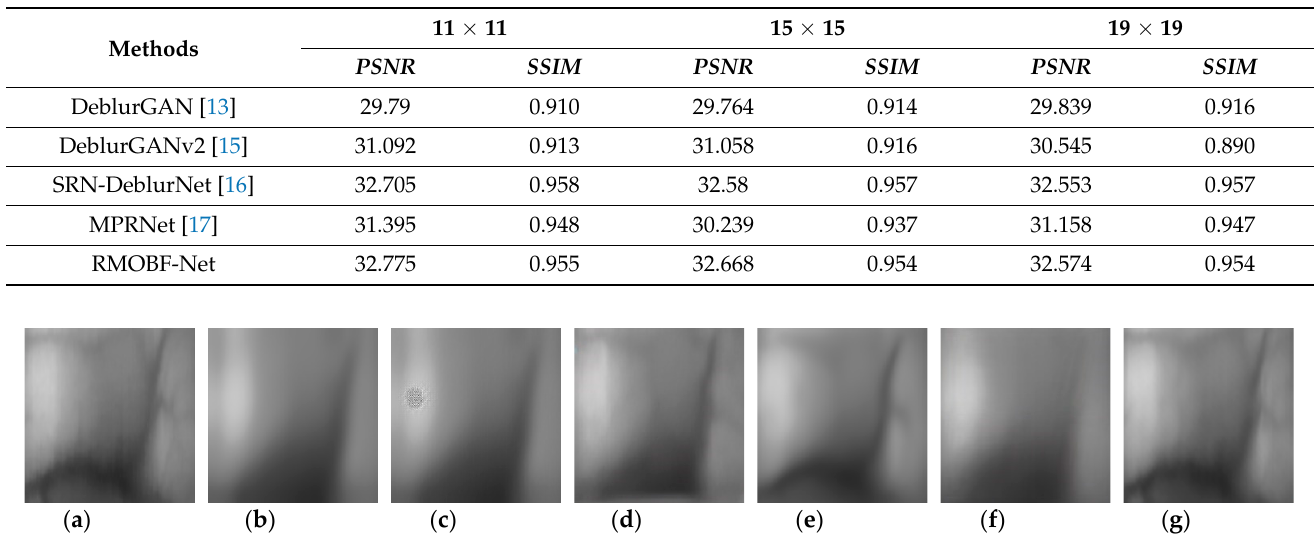
Table 3. Comparisons of motion and optical blur restoration performance of SDU-DB by state-of-the- art methods and proposed RMOBF-Net (11 × 11, 15 × 15, and 19 × 19 mean the size of Gaussian blur filter).